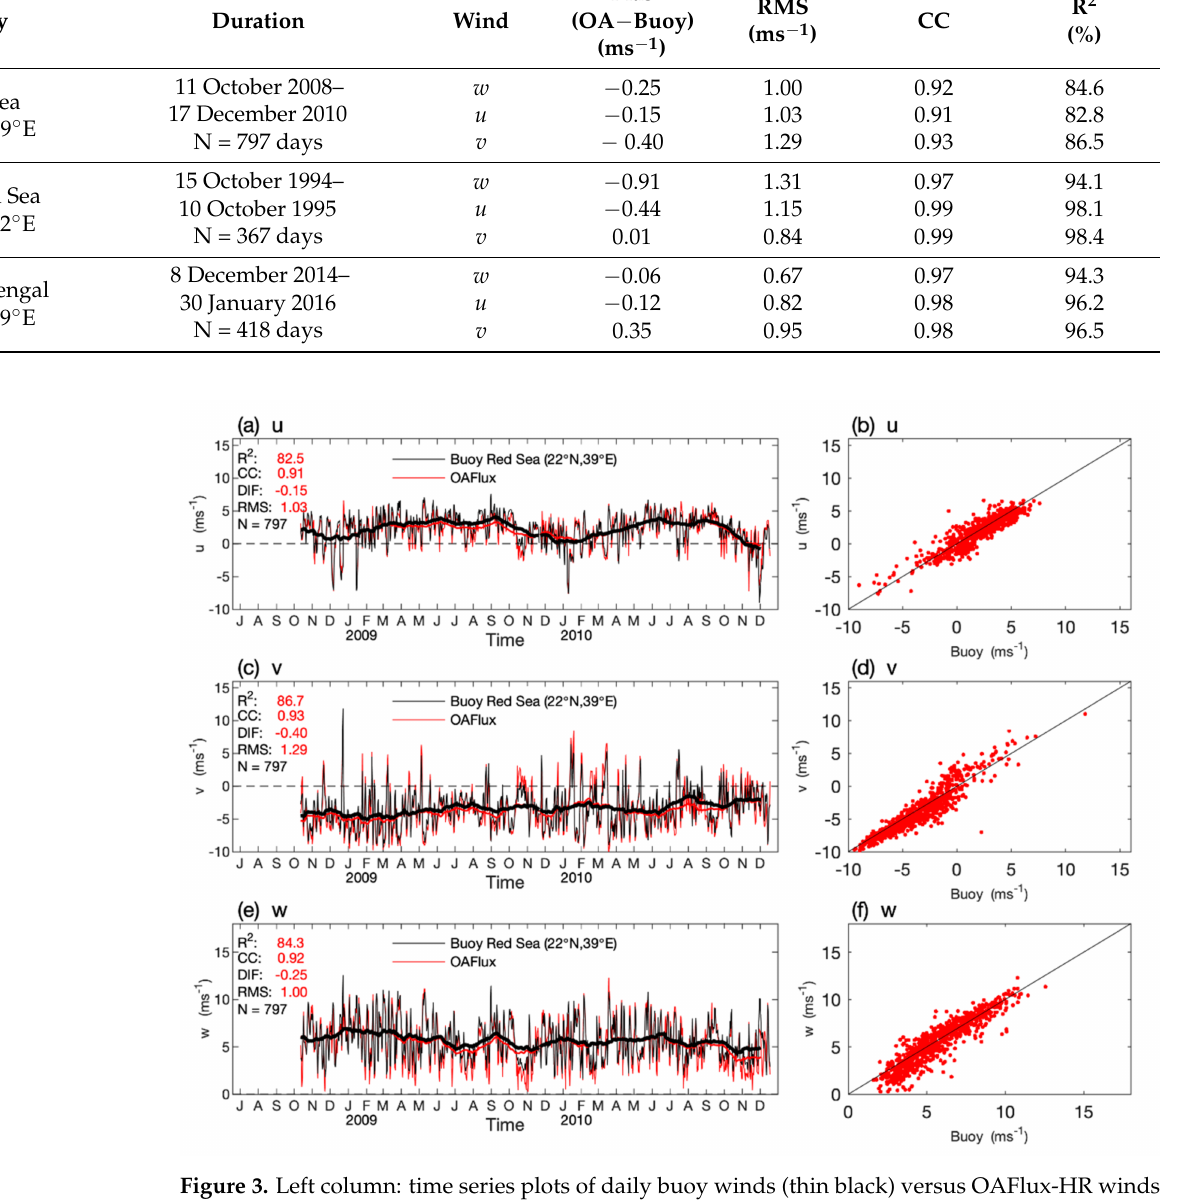
Figure 3. Left column: time series plots of daily buoy winds (thin black) versus OAFlux-HR winds (thin red). Right column: scatter plots of collocated pairs at the Red-Sea buoy location 22 ◦ N, 39 ◦ E. ( a , b ) zonal wind component, ( c , d ) meridional wind component, ( e , f ) wind speed. Thick smoother lines in ( a , c , e ) denote a 21-day running mean with black for buoy and red for OAFlux-HR. The WHOI buoys are equipped with the Improved METeorology (IMET) or Air Sea Interaction–METeorology (ASIMET) systems, and the expected errors are about ± 0.1 m s − 1 (or 1%) in wind speed and 5 ◦ in wind direction [54]. Table 3 shows that the correlations between OAFlux-HR daily winds and buoy daily winds exceed 0.9 at all three sites, and the R 2 values, which represent the variances shared between the two independent sets of daily winds, range from ~84% (Red Sea buoy) to ~98% (Arabian Sea